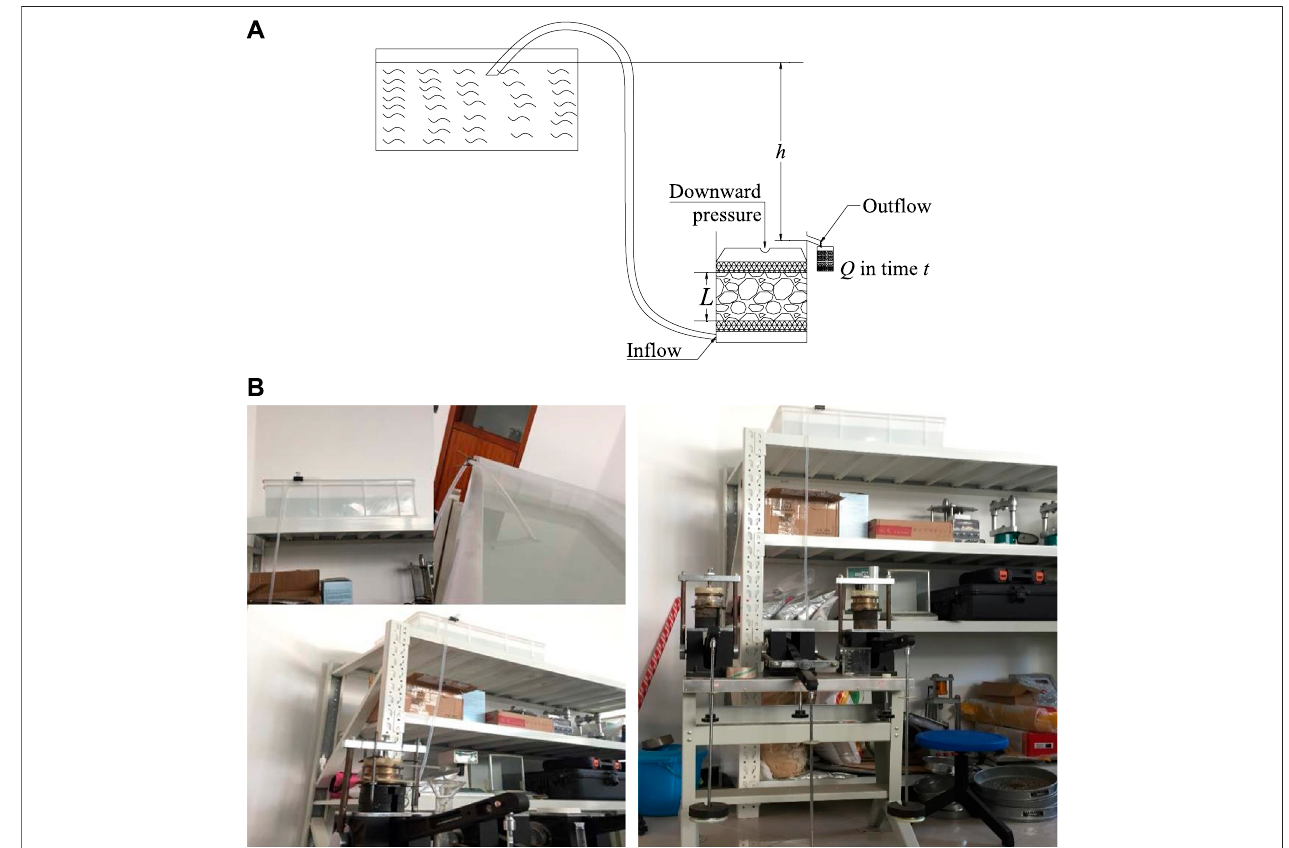
FIGURE 3 | Constant-head permeability test. (A) Schematic diagram of constant-head permeability test under effective pressure; (B) laboratory constant-head permeability test under effective stress in progress.